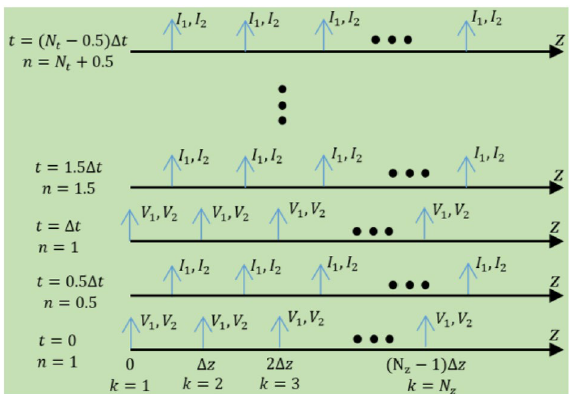
Figure 2. Representation of FDTD scheme for full wave simulation of space–time coupled transmission lines. V